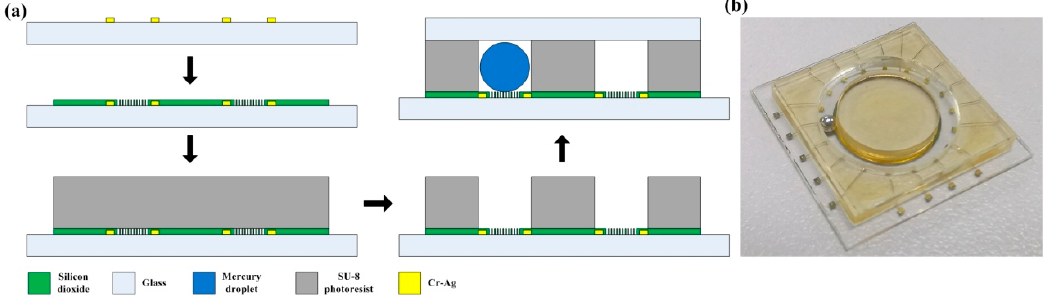
Figure 12. ( a ) Schematic diagram of the manufacture process, ( b ) fine processed sensor.